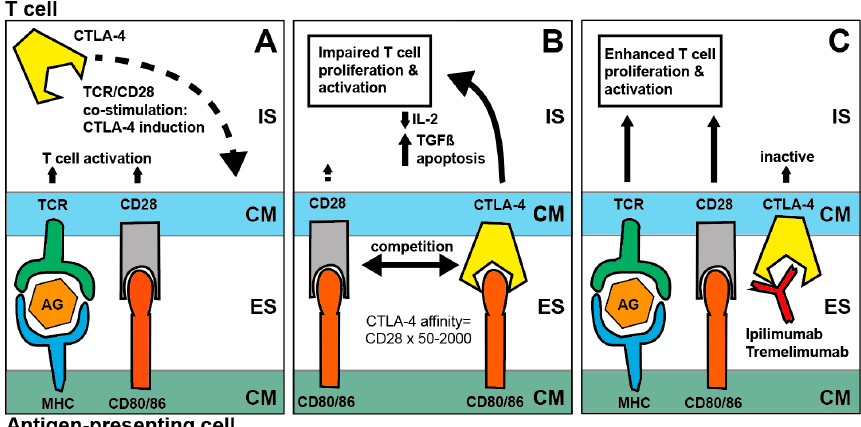
Figure 2. Mechanism of CTLA-4 blockade. ( A ): Co-stimulation of TCR / CD28 induces CTLA-4 receptor expression, ( B ): Interaction of CTLA-4 and CD80 / 86 inhibits IL-2 signaling, promotes apoptosis and the secretion of immunosuppressive i cytokines, such as TGF β , ( C ): CTLA-4 receptor blockade by ipilimumab or tremelimumab enhances T cell activation and